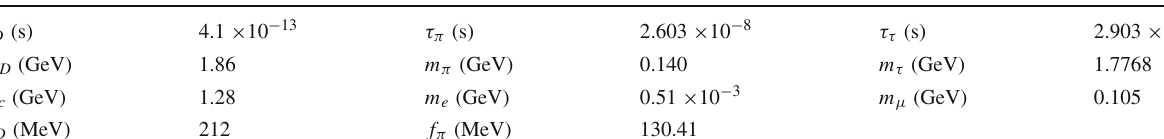
Table 1 Numerical values of parameters used in our calculation, taken from PDG [32]